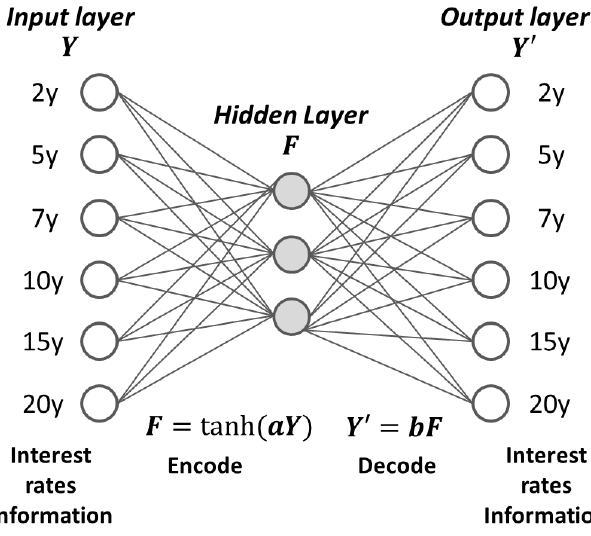
Figure 6. Autoencoder model constructed with interest rate data.